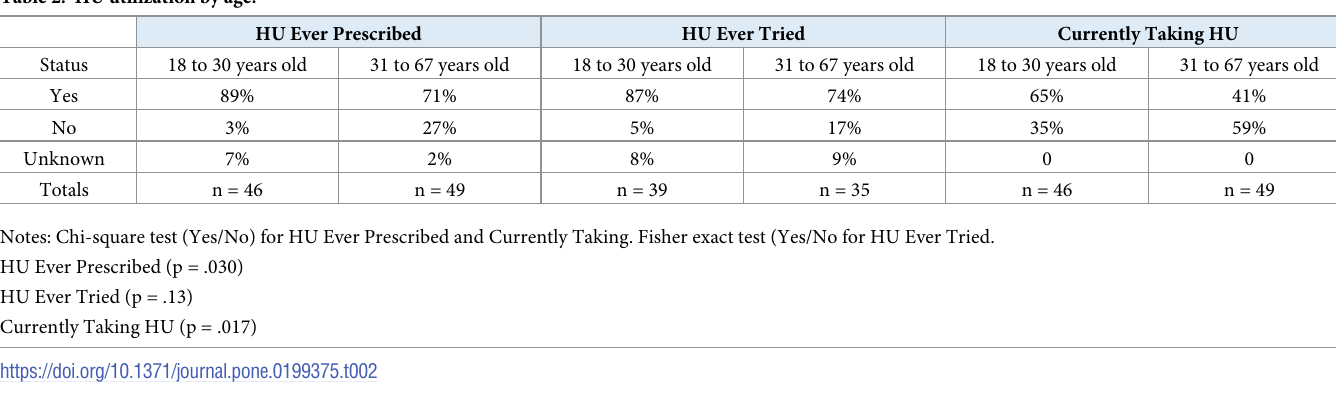
Table 2. HU utilization by